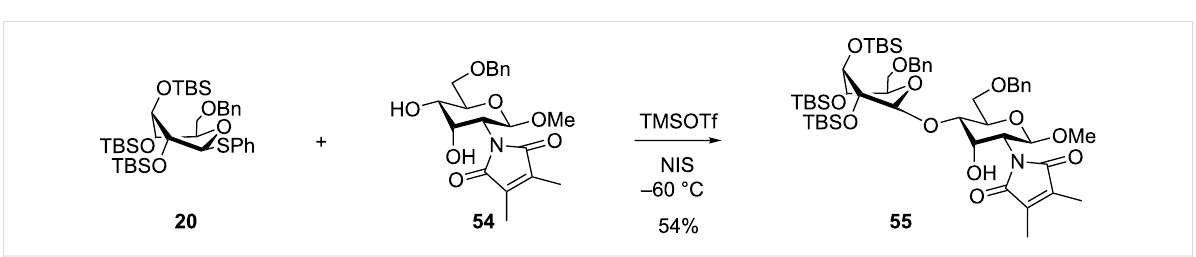
Scheme 9: Regio- and stereoselective glycosylation using the superarmed thioglycoside donor 20